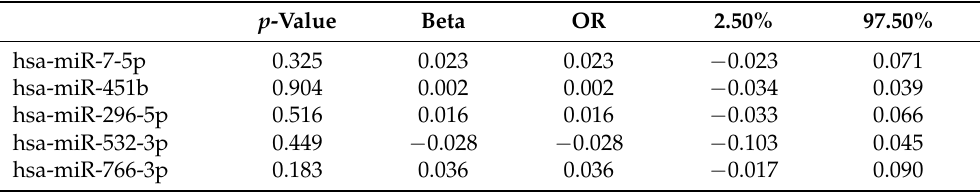
Figure 1. ( A ) Differential expression of miRNA between frequent and no or infrequent exacerbations in the GACRS. Green and red color circles indicate up and downregulated miRs, respectively. Mean expression shown in log2 scale. ( B ) Clustered heat map of all 20 differentially expressed miRs across conditions in the GACRS. DESeq-2 normalized expression counts (shifted logarithm transformation) were used. Unsupervised hierarchical clustering was used to generate the heat map and Pearson correlation was used as the distance metric. Table 6. List of replicated up and downregulated miRNAs and association with total Eosinophil count. p -value: computed with DESeq2. Beta and Odds Ratio (OR) from logistic regression are for a doubling of miR counts. 2.50%: lower bound of 95% confidence interval of odds ratio. 97.50%: upper bound of 95% confidence interval of odds